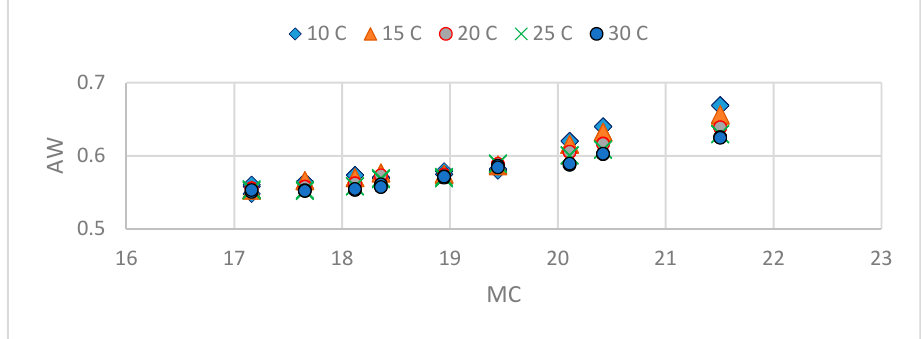
Figure 2. Effect of temperature on the water activity (Aw)/moisture content (MC) data of floral honey. Table 3. Estimated values of parameters in the linear equation.